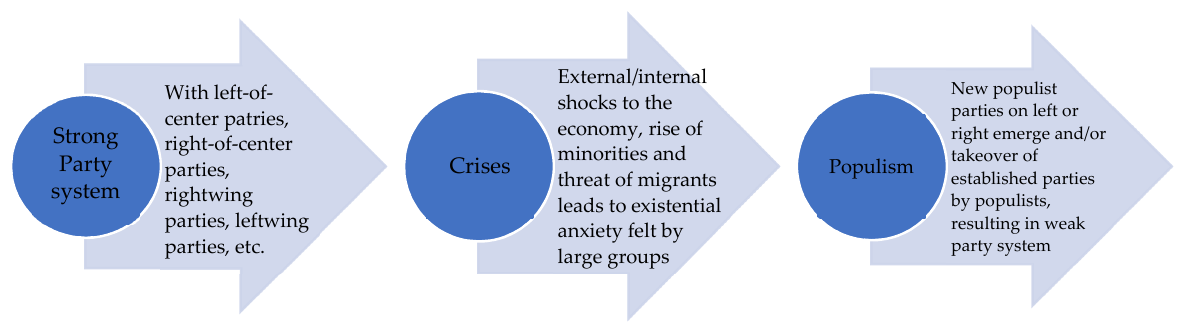
Figure 1. Loss of legitimacy and rise of populism.